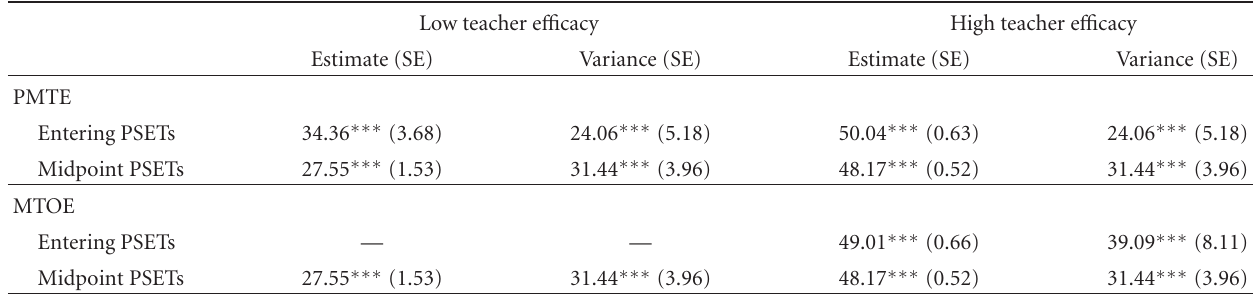
Table 3: Mean Estimates and Variances of Latent